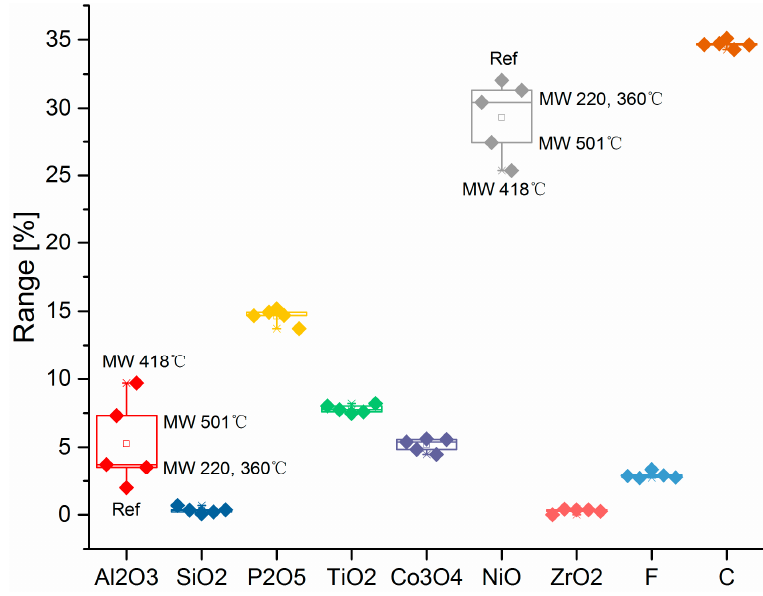
Figure 5. Variation of elements in the active mass during microwave pyrolysis.